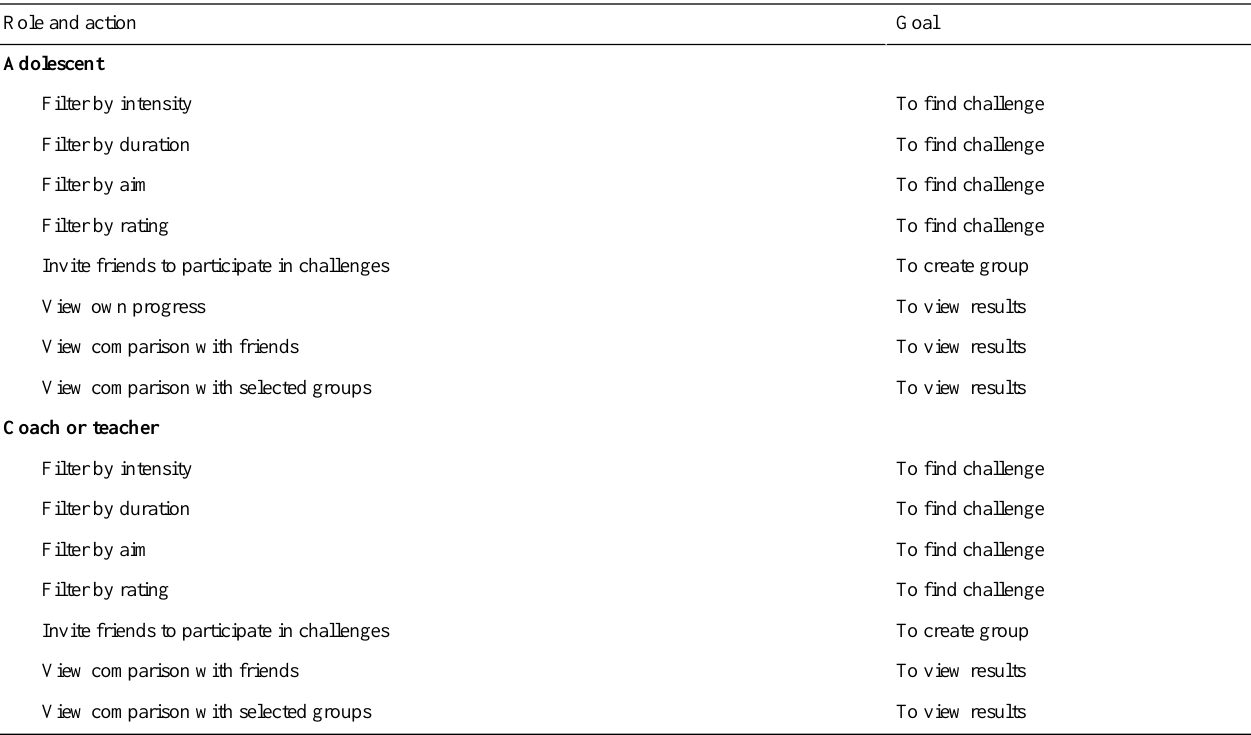
Table 1. User stories for the submodel “Participate in